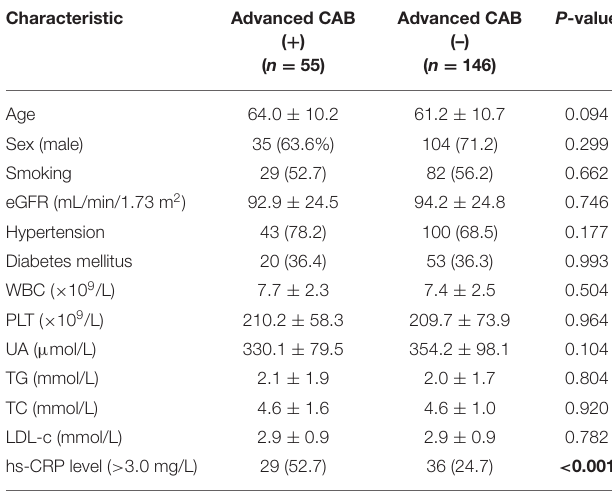
TABLE 1 | Baseline clinical data distribution according to cerebral atherosclerosis burden.